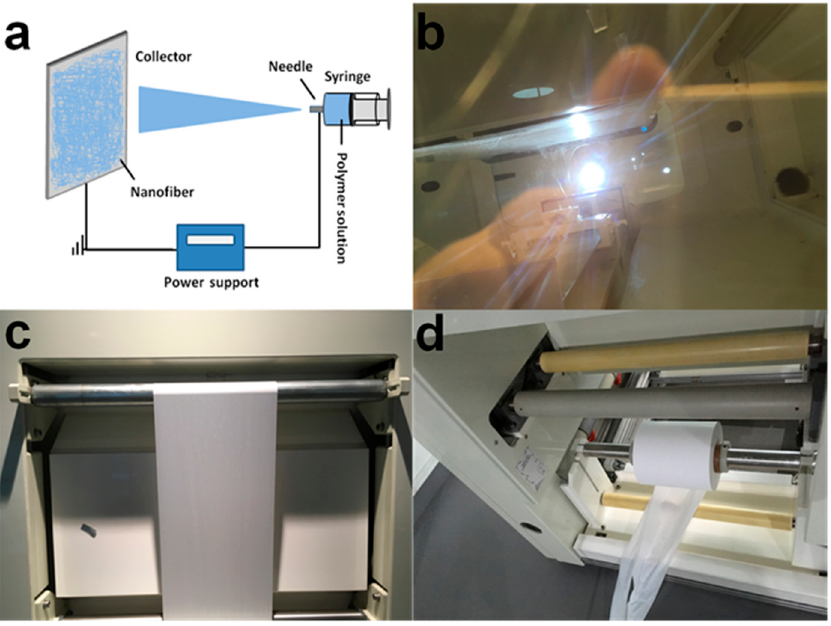
Figure 1. ( a ) Schematic illustration of the electrospinning; ( b – d ) photography of mass production for composite separator by free-liquid surface electrospinning.